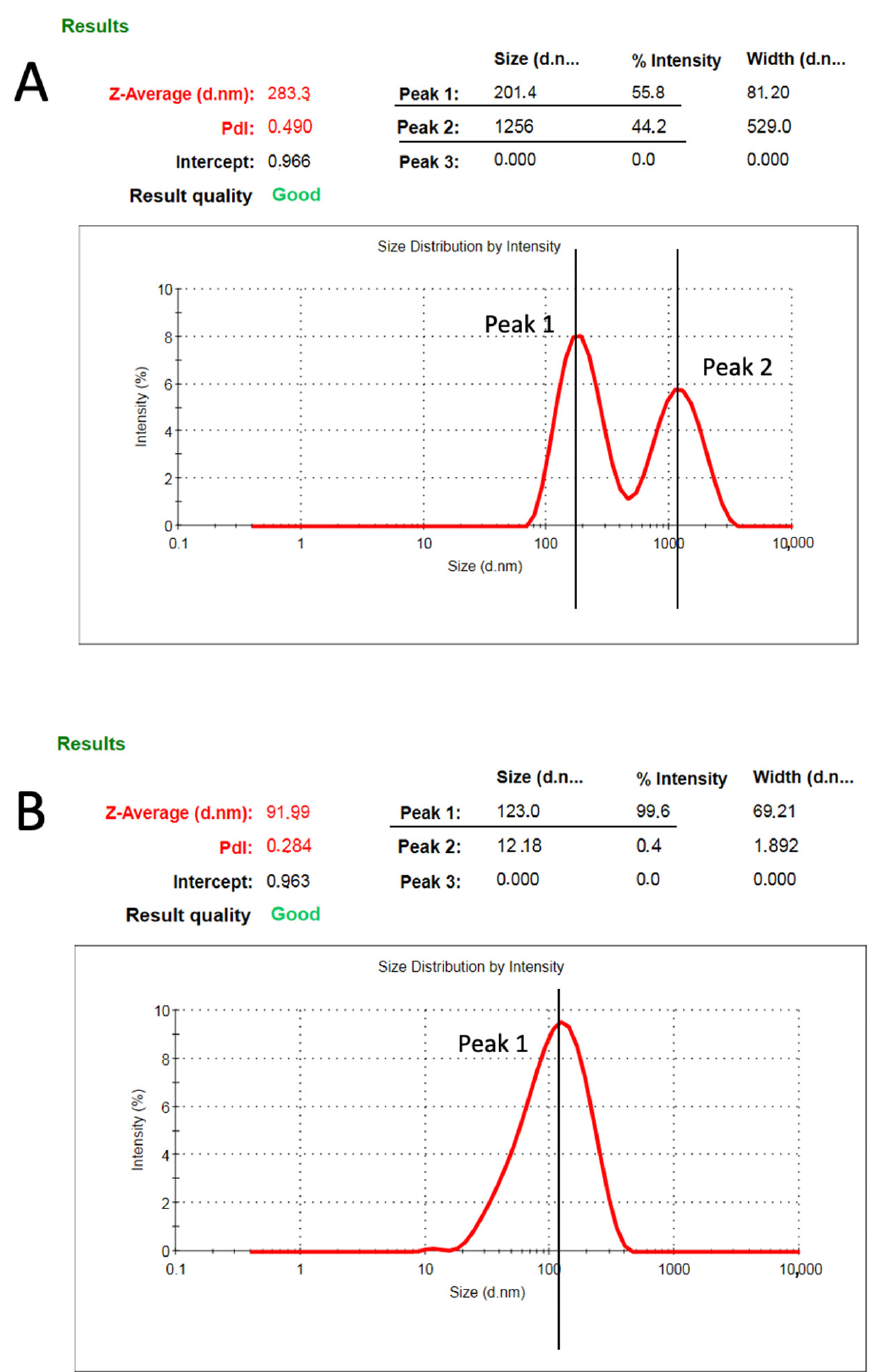
Figure 2. ζ -Potential measurements of particles in the C2C12 culture medium, following centrifuga- tion at 15,000 × g (large EVs, ( A )) and at 110,000 × g (small EVs, ( B